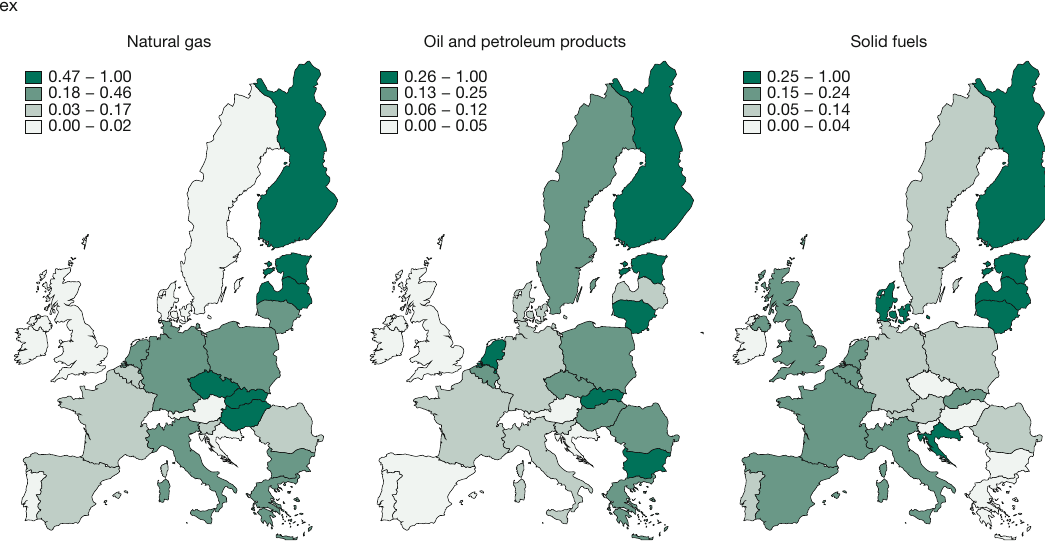
EU member states’ dependency on energy imports from Russia,